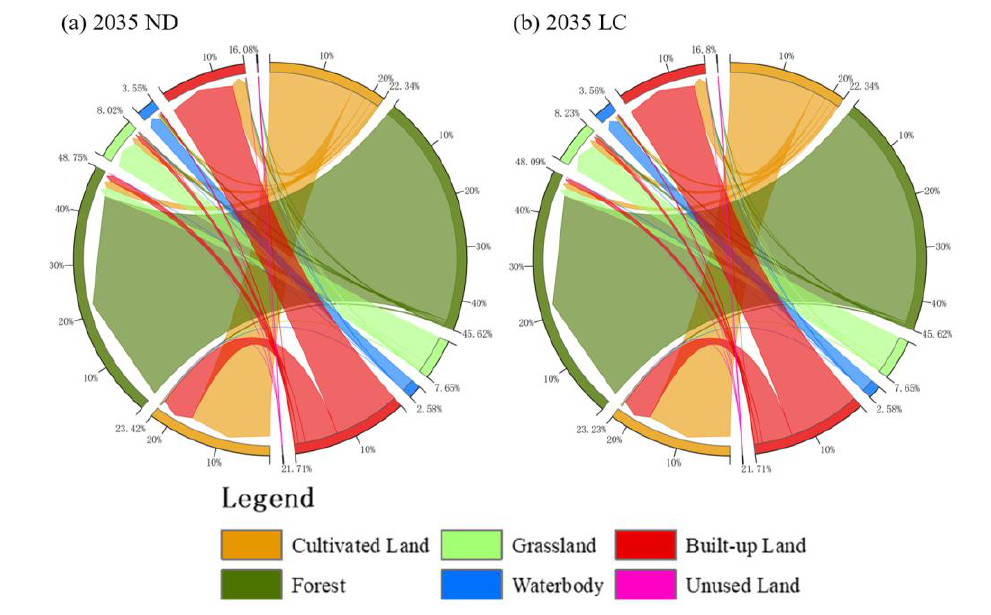
Figure 5. The relationship between land use conversion in 2020-2035 ((a) represents 2020–2035 ND Scenario, (b) represents 2020– 2035 LC Scenario. The beginning of the arrow indicates the land proportion in the baseline year, and the arrow points to the land proportion in the target year).